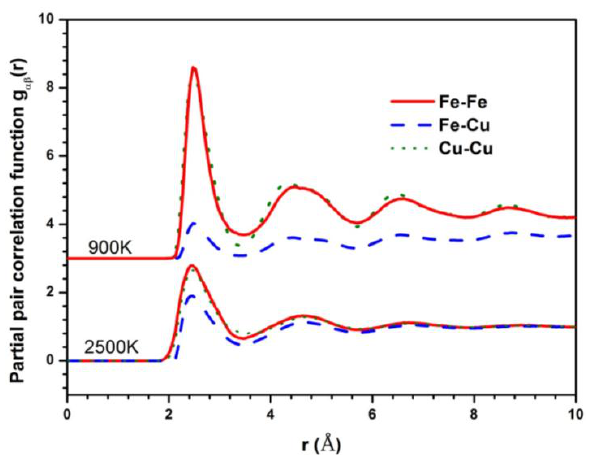
Figure 2. Partial pair correlation functions (PPCFs) of Fe 50 Cu 50 at 2500 K and 900 K respectively.